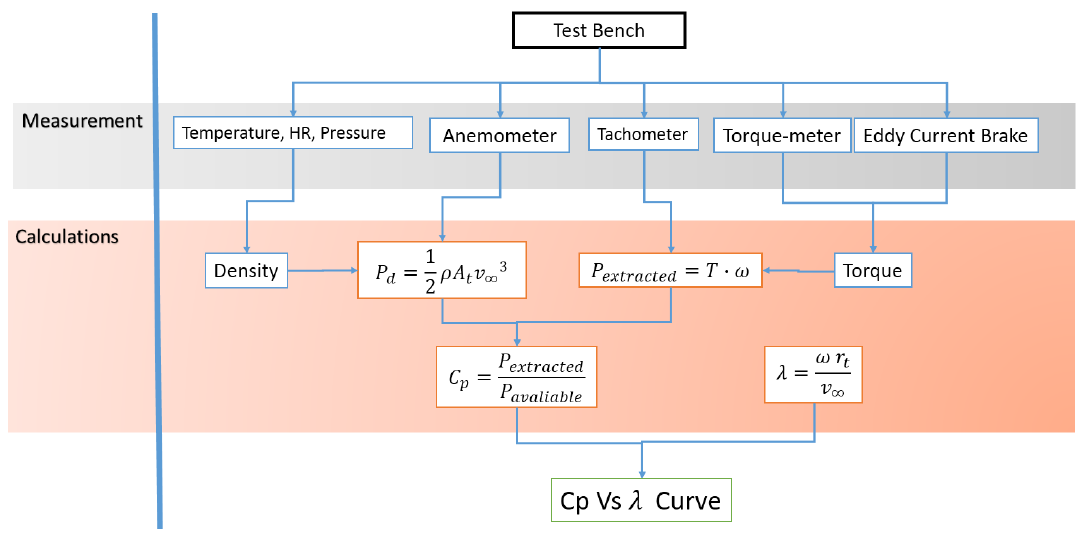
Figure 2. Schematic Cp curve measurement method.